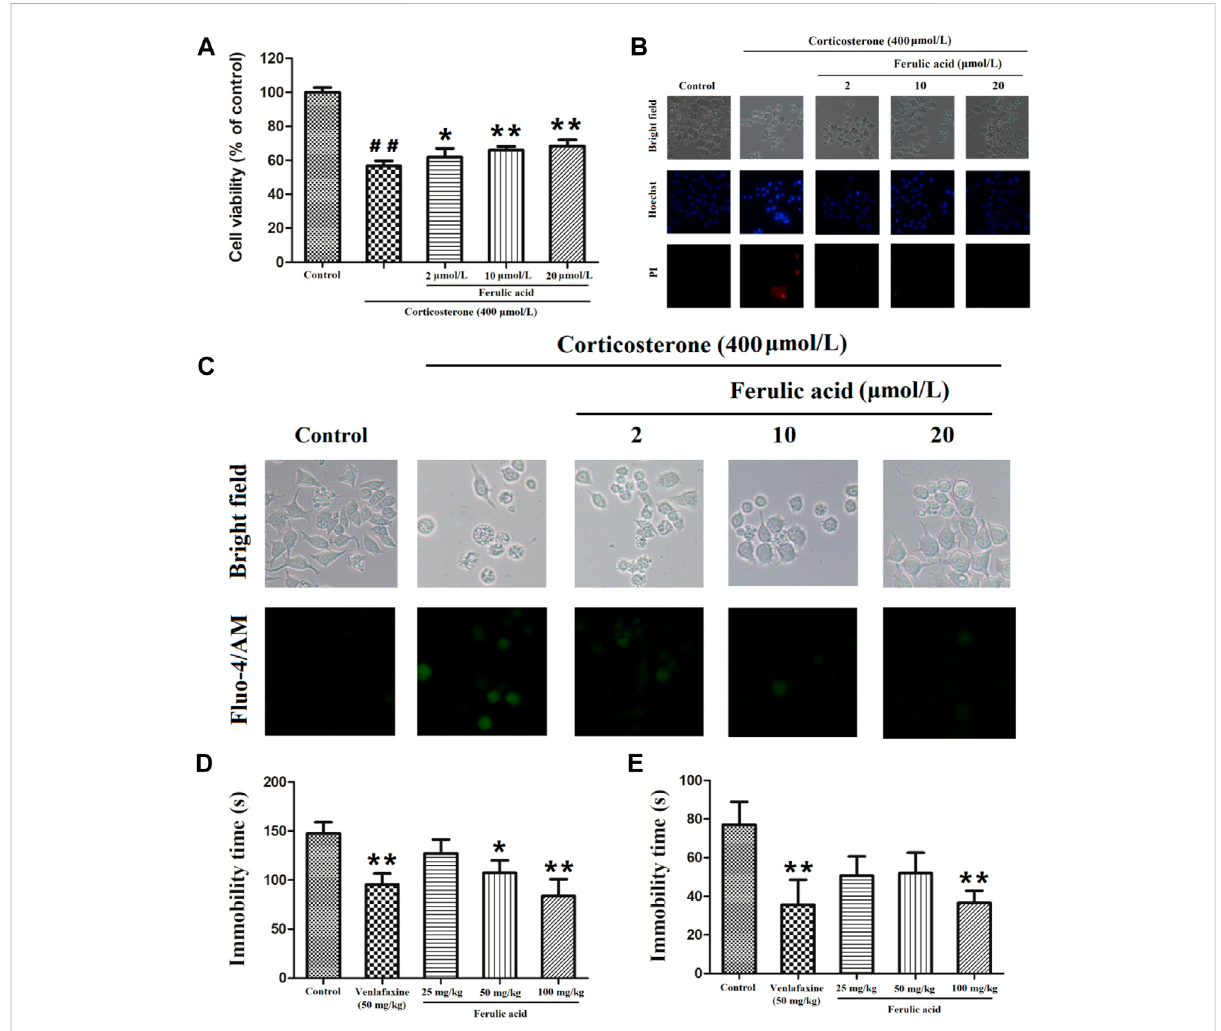
FIGURE 10 Antidepressanteffectvalidationofakeycomponent(FA)inFCGofDSS. (A) ProtectiveeffectofFAoncorticosterone-inducedPC12cells( n =4). ## P < 0.01, compared with the control group; * P < 0.05 or ** P < 0.01, compared with the corticosterone-treated group; (B) cell survival analyzed by Hoechst 33342 and PI double staining; (C) representative Fluo-4/AM staining images of intracellular Ca 2+ ; (D) effect of FA on the immobility time in theforcedswimtest( n =10); (E) effectofFAontheimmobilitytimeinthetailsuspensiontest( n =10).Drugswereorallyadministeredoncedaily for 14 days; the tail suspension test was conducted at the 13th day, and the forced-swimming test was conducted at the 14th day. * P < 0.05, ** P < 0.01, compared with the vehicle